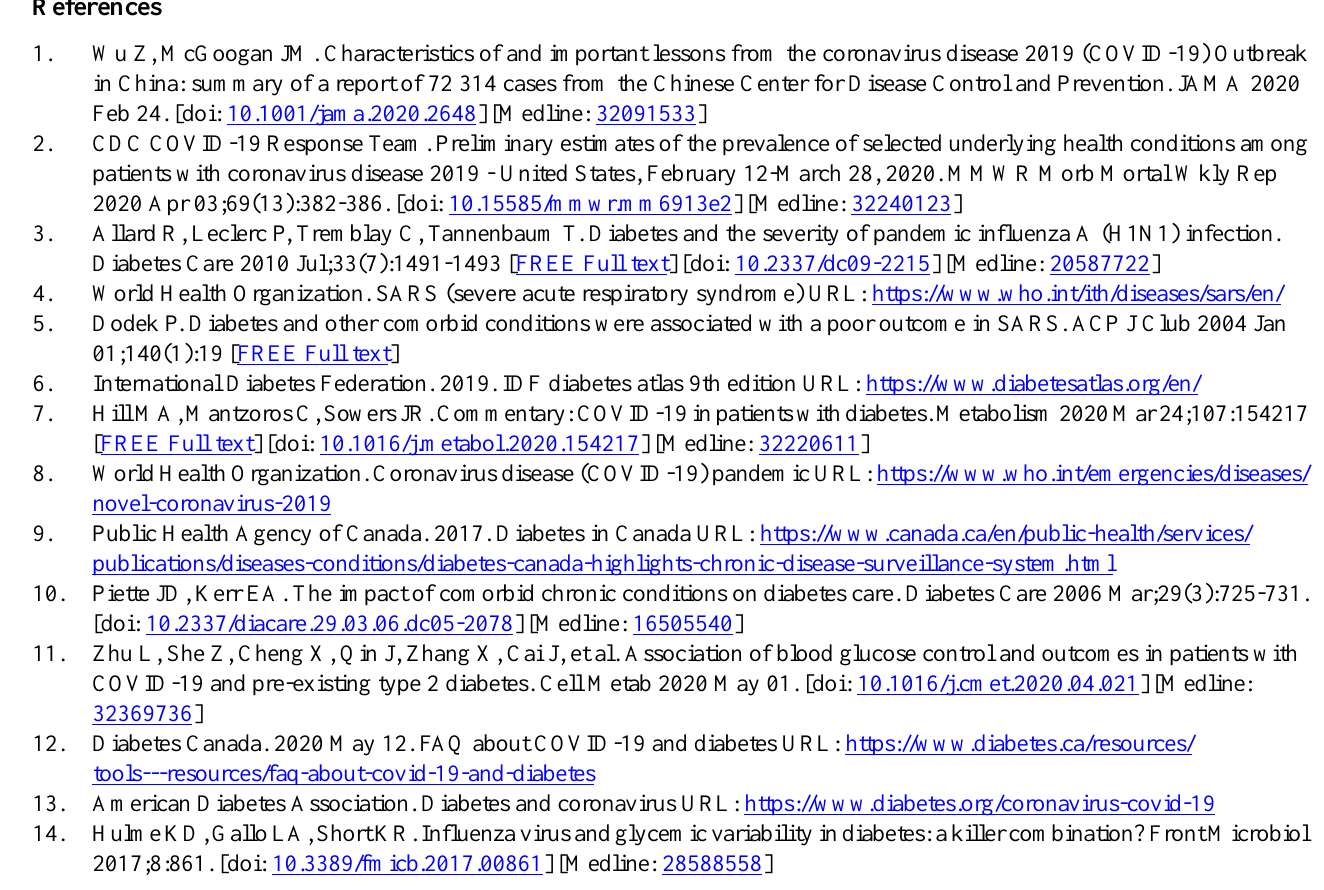
Conflicts of Interest None